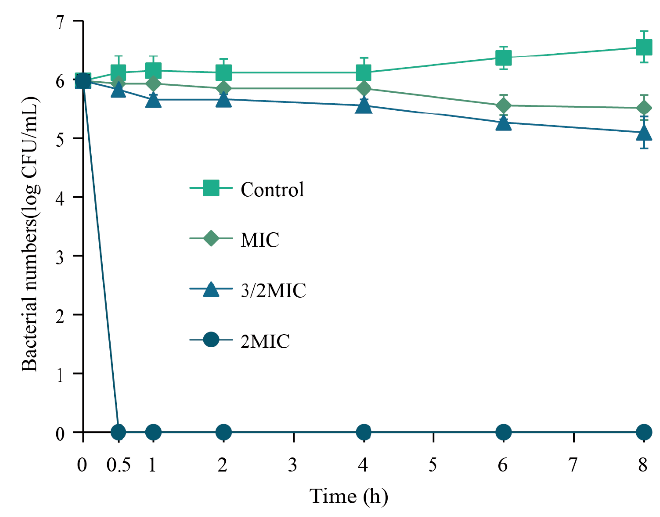
Figure 4. Inactivation effect of eugenol on Sh. flexneri in vegetable juice.